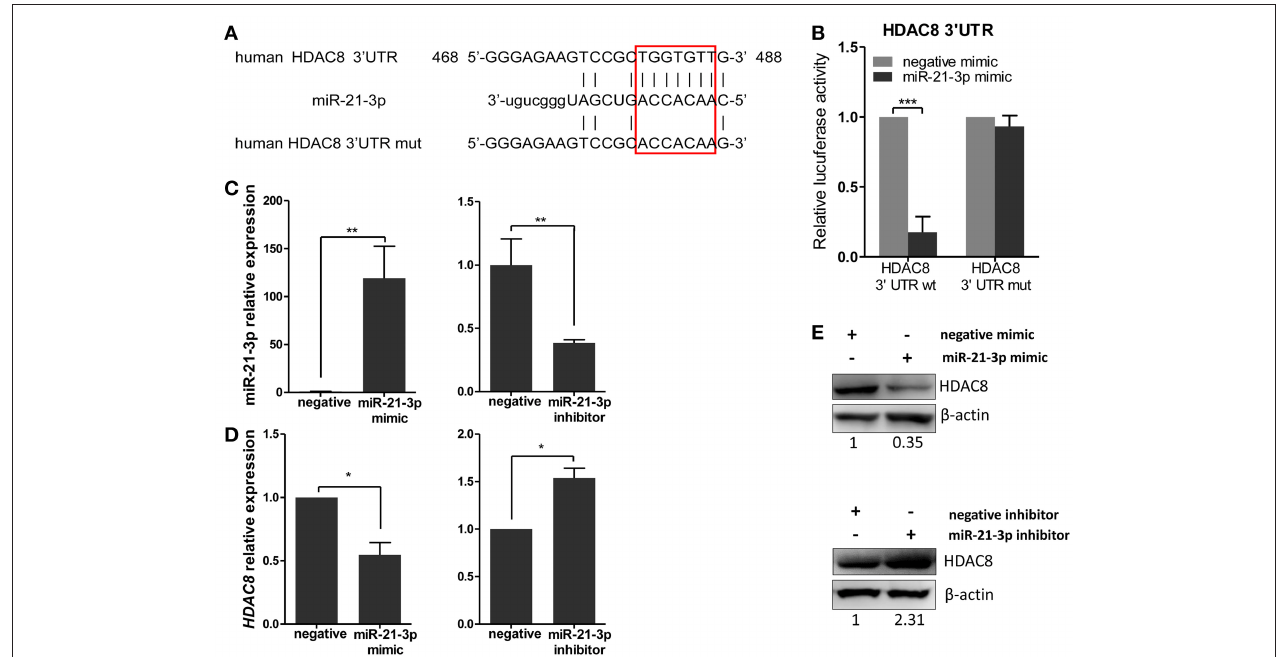
FIGURE 6 | miR-21-3p directly targets the 3 ′ UTR of HDAC8. (A) Schematic representation of predicted target sites of miR-21-3p in the 3 ′ UTR of HDAC8 and mutant HDAC8 3 ′ UTR reporter constructs. (B) 293FT cells were co-transfected with pMIR-HDAC8-3 ′ UTR luciferase reporter plasmid, pMIR-HDAC8-3 ′ UTR mut luciferase reporter plasmid and pRL-TK plasmid, together with negative mimic or miR-21-3p mimic (50nM). After 24h, firefly luciferase activity was measured and normalized by Renilla luciferase activity. Data are the mean ± SD from four independent experiments. *** P < 0.001 vs. negative mimic by t -test. (C) A549 cells were transfected with miR-21-3p mimic or negative mimic (left), miR-21-3p inhibitor or negative inhibitor (right) at a final concentration of 50 and 100nM, respectively. After 24h, miR-21-3p expression was measured. Data are the mean ± SD of triplicate samples from a single experiment and are representative of two independent experiments. ** P < 0.01 vs. negative control by t -test. (D) A549 cells were transfected with mimics or inhibitors of miR-21-3p and their negative control. After 24h, the HDAC8 mRNA level was detected by real-time qPCR and normalized to expression of GAPDH. Data are the mean ± SD from three independent experiments. * P < 0.05 vs. negative control by t -test. (E) A549 cells were transfected with mimics or inhibitors of miR-21-3p and their negative control. After 48h, HDAC8 protein expression was analyzed by Western blot. β -actin was used as loading control. Data are representative of three independent